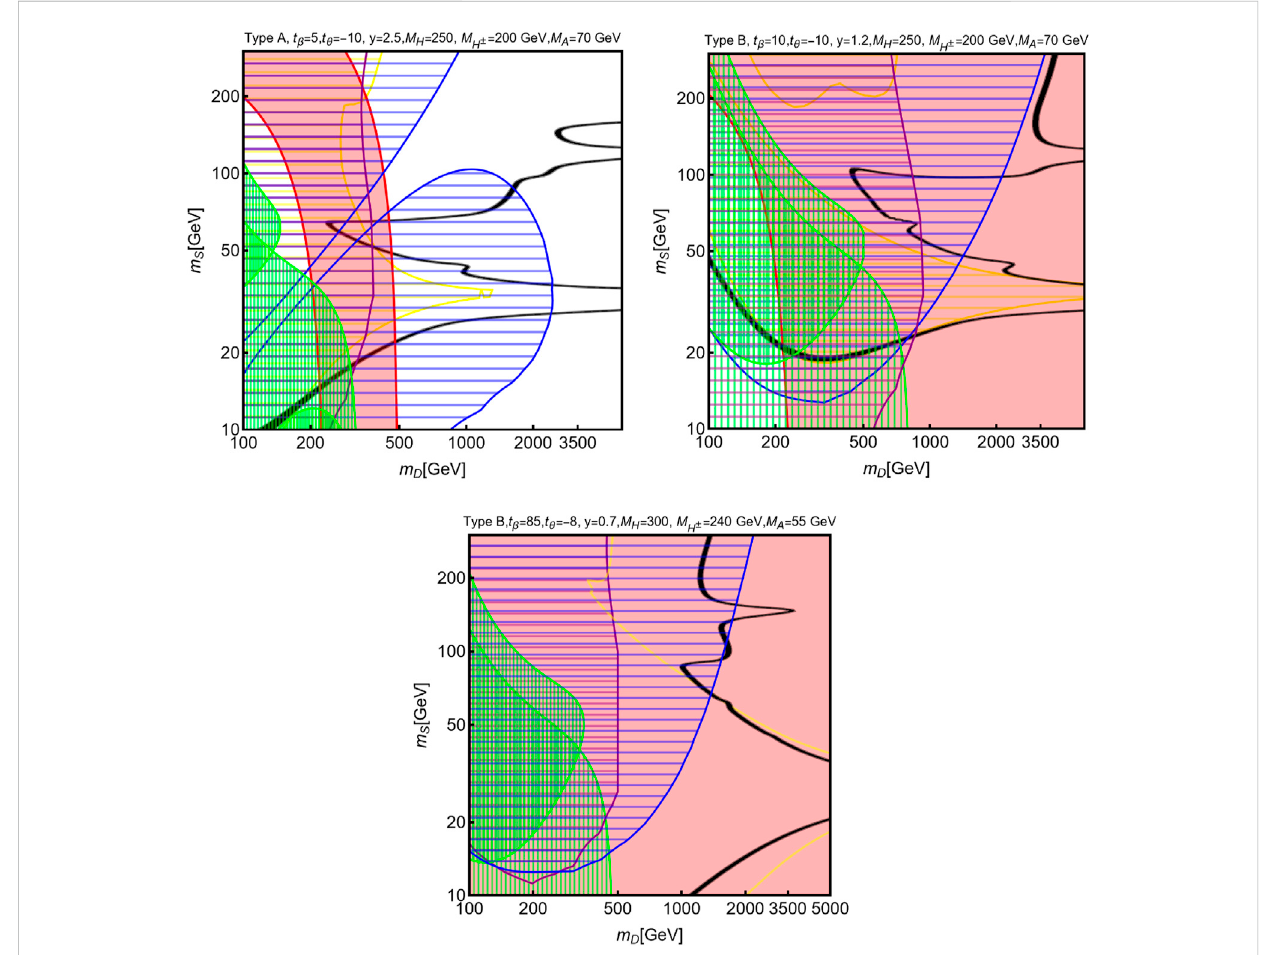
FIGURE 6 Combined constraints on the singlet – double 2HDM scenario in the [ m D , m S ] plane for three benchmarks in the type-X con fi guration, with input parameters given on top of each plot. The color convention is the same as that in Figure